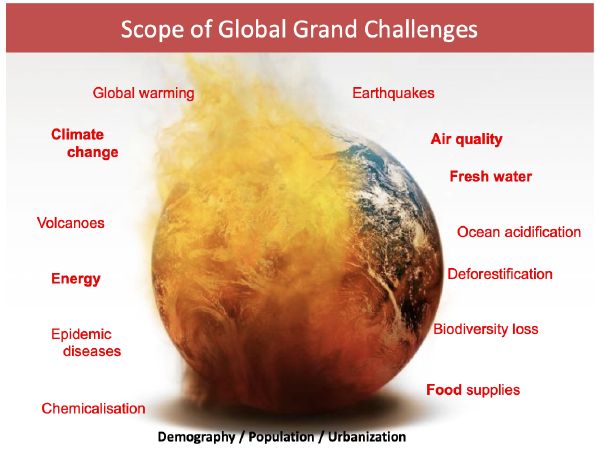
Figure 1. The burning planet and the scope of interlinked grand challenges. The main driving forces behind these challenges are the growth of population and gross domestic production globally, as well as the growth of urbanization, which is closely related to the two former trends. The growing population needs clean air, more fresh water, food and energy, which will cause challenges such as climate change, declining air quality, ocean acidification, loss of biodiversity and shortages of fresh water, food and energy supplies, as well as regional and even global epidemic